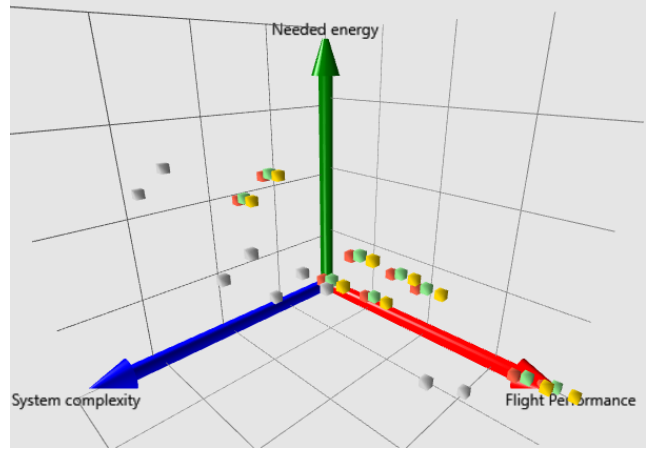
Figure 10. Option distribution for the morphing technology attribute. Gray—mechanical extensions (flaps, slats); yellow—contour morphing; green—memory alloys; red—piezoelectric plates. The solution space is zoomed for a better visibility of all